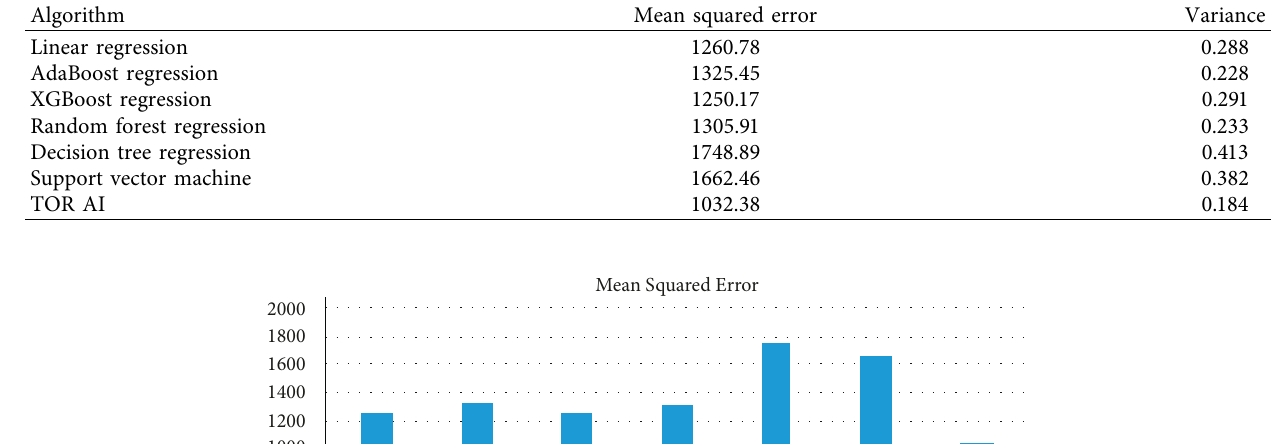
Table 2: The mean squared error and the variance report.